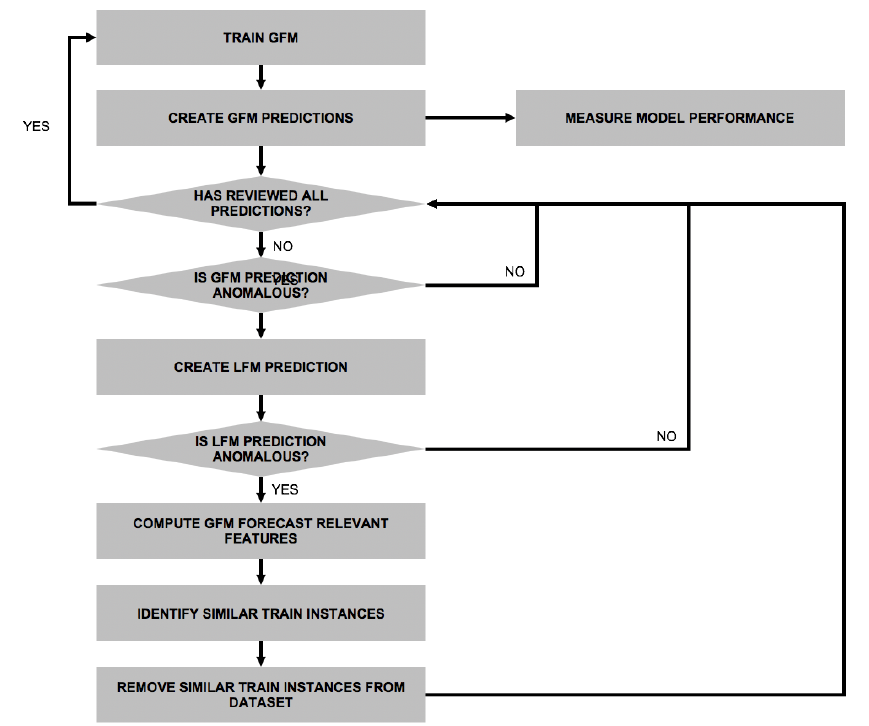
Figure 2. Fluxogram detailing the methodology that we applied to identify anomalous forecasts, most similar instances in the train set, and their treatment to enhance the performance of